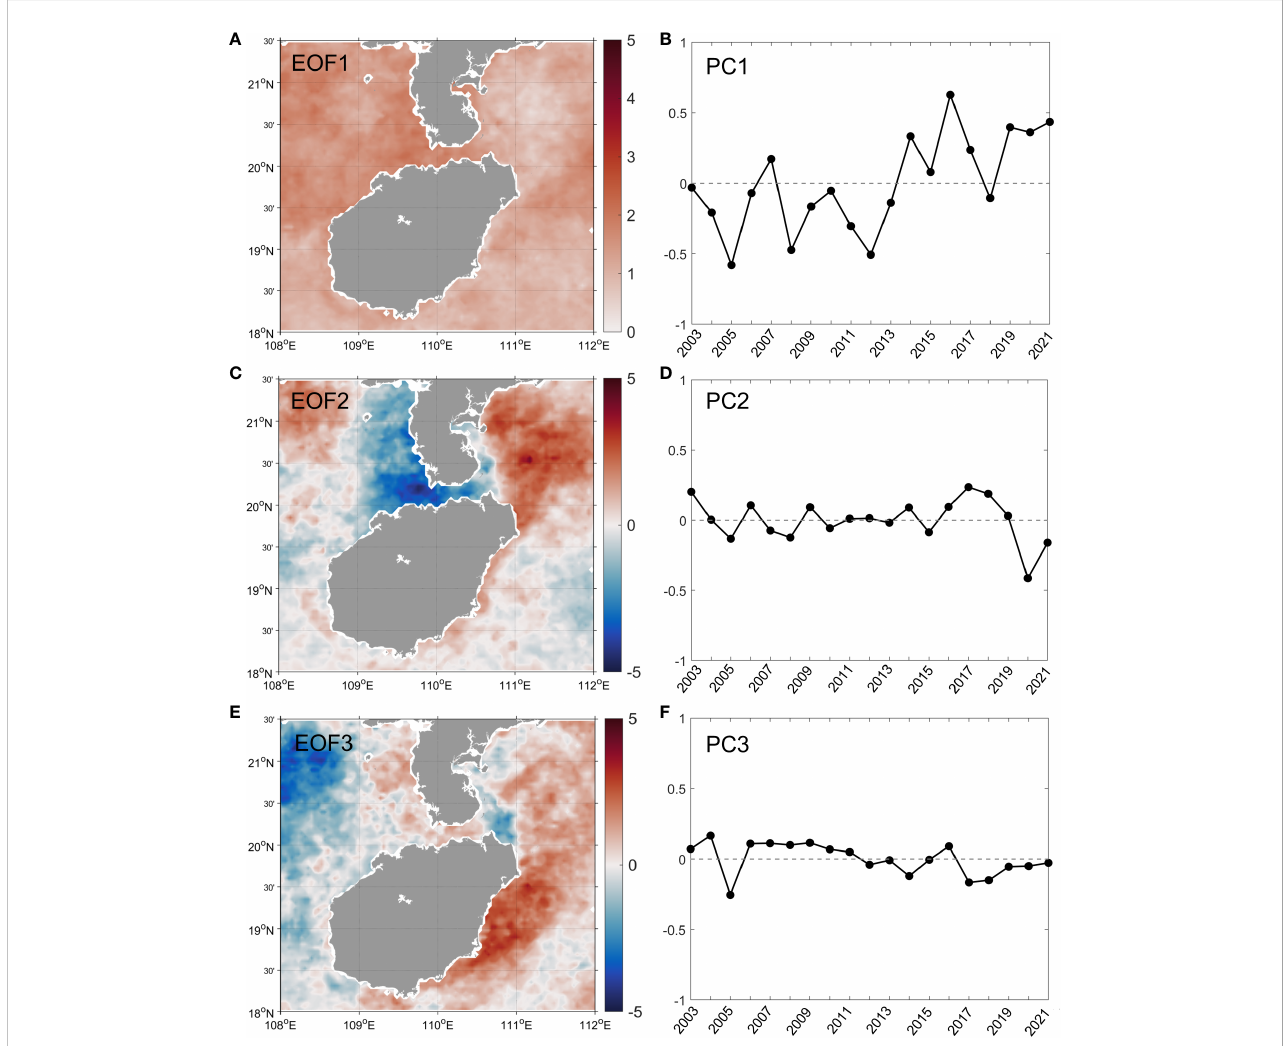
FIGURE 5 Spatial distribution (A, C, E) and principal component time series (B, D, F) of the fi rst three modes of empirical orthogonal function